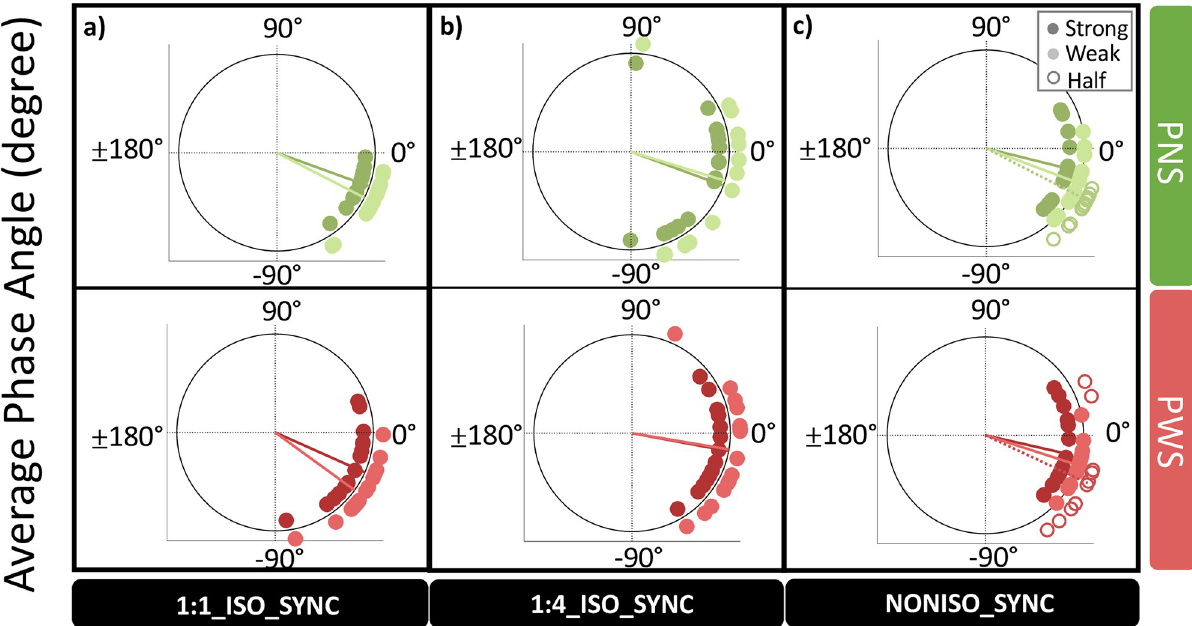
Fig 6. Average Phase Angle on the “strong” vs. “weak” beats of a 8-beat isochronous pattern, in which all the beats were marked by an auditory stiumulus (1:1_ISO_SYNC), or only the strong ones (1:4_ISO_SYNC), and on the “half-beat” pulses of a non-isochronous pattern (NONISO_SYNC). People who stutter (PWS, N = 16) are compared to with matched control particpants without speech disorders (PNS, N = 16).